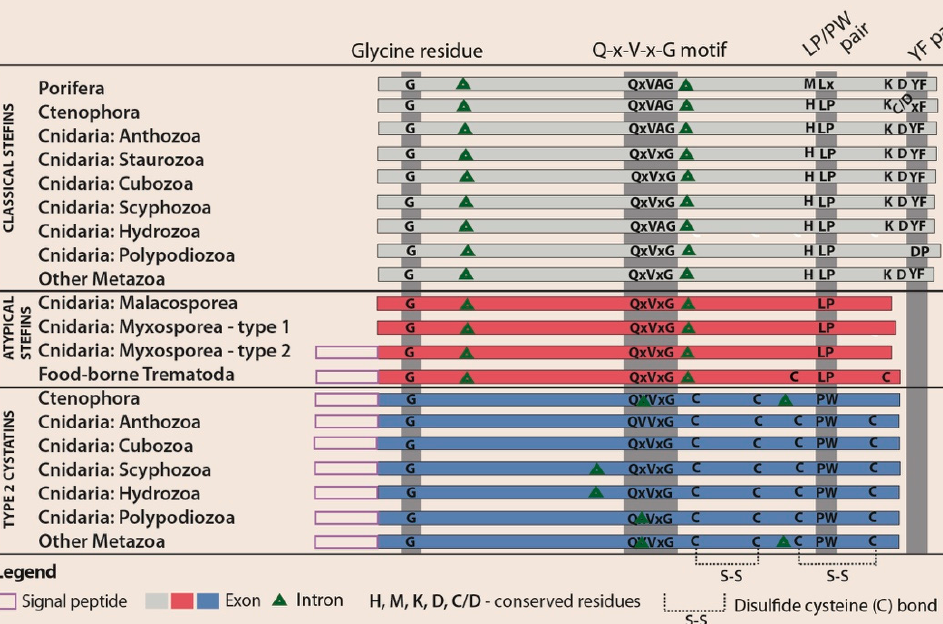
Figure 2. Schematic comparison of the gene architecture and amino acid structure of metazoan cystatins: for myxozoans, information is shown separately for Malacosporea and Myxosporea.